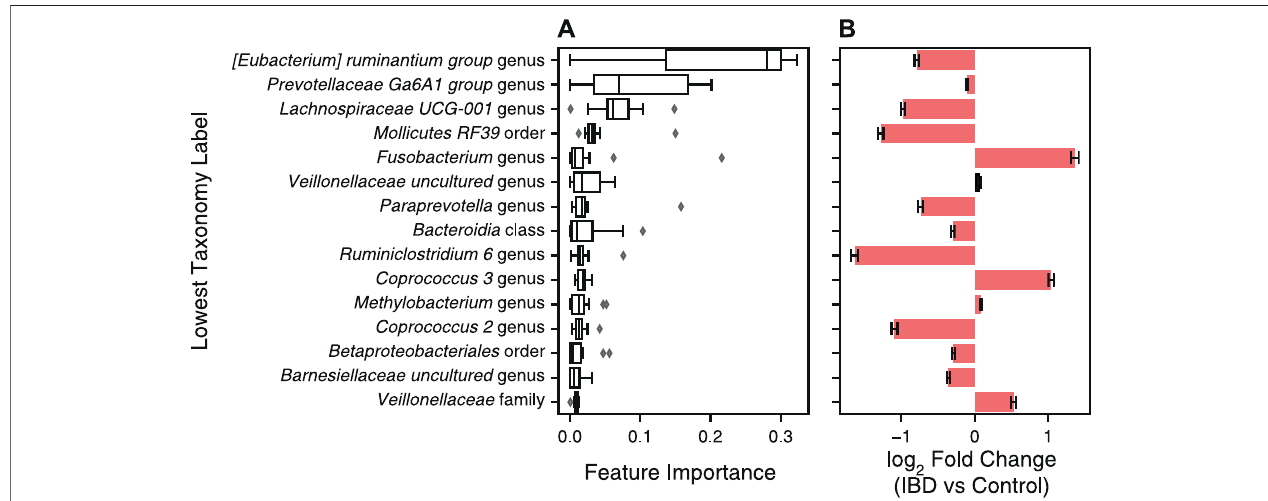
FIGURE 8 | Features with greatest contribution to IBD classi fi cation with XGBoost classi fi er. (A) A XGBoost classi fi er was trained with CLR normalized genus abundance features with zero-centered batch effect correction for fi fteen LODO iterations. The features ’ gain values for each iteration were extracted and sorted by the mean gain across all iterations. Error bars represent mean ± standard error of the mean for the fi fteen iterations. The lowest classi fi cation rank for each feature was used as the label for the corresponding bar. (B) Changes in taxonomy abundance between control samples and those from patients with IBD. Bars represent the fold change ± the standard error determined with Analysis of Compositions of Microbiomes with Bias Correction (ANCOM-BC). Red indicates a signi fi cant fold change between IBD and control samples ( p < 0.05) and black indicates non-signi fi cant fold change.